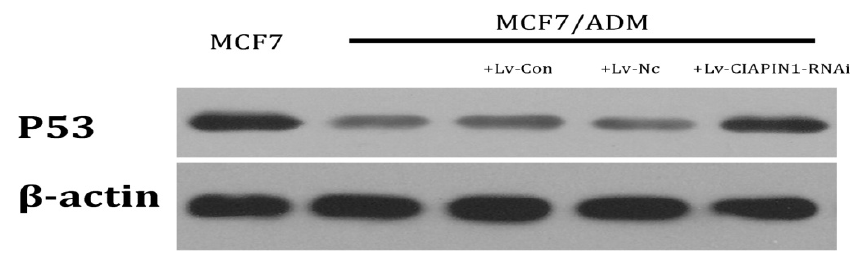
Figure 10. Expression of P53 Protein in Breast Cancer Cell Lines Before and After RNAi by Western